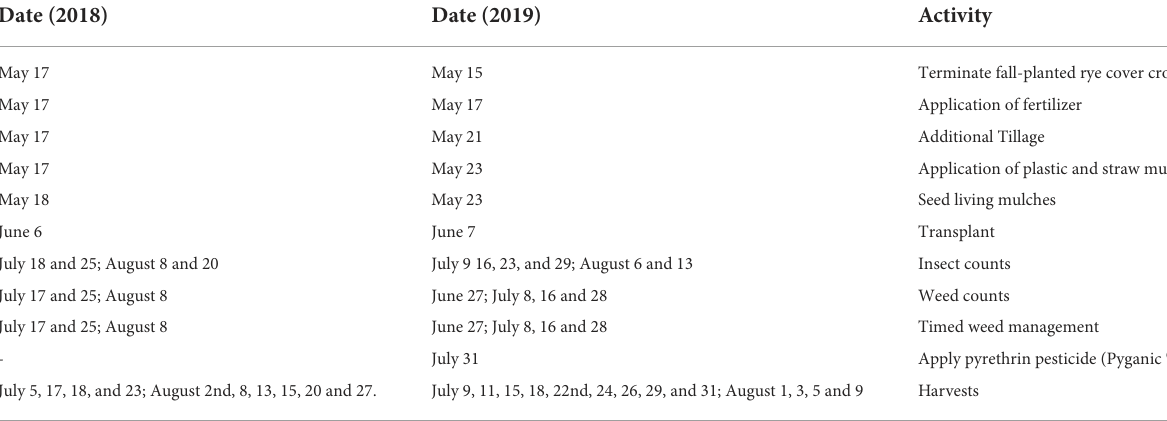
TABLE 1 Summary of field activities for living mulch management of organic squash, 2018 and 2019.